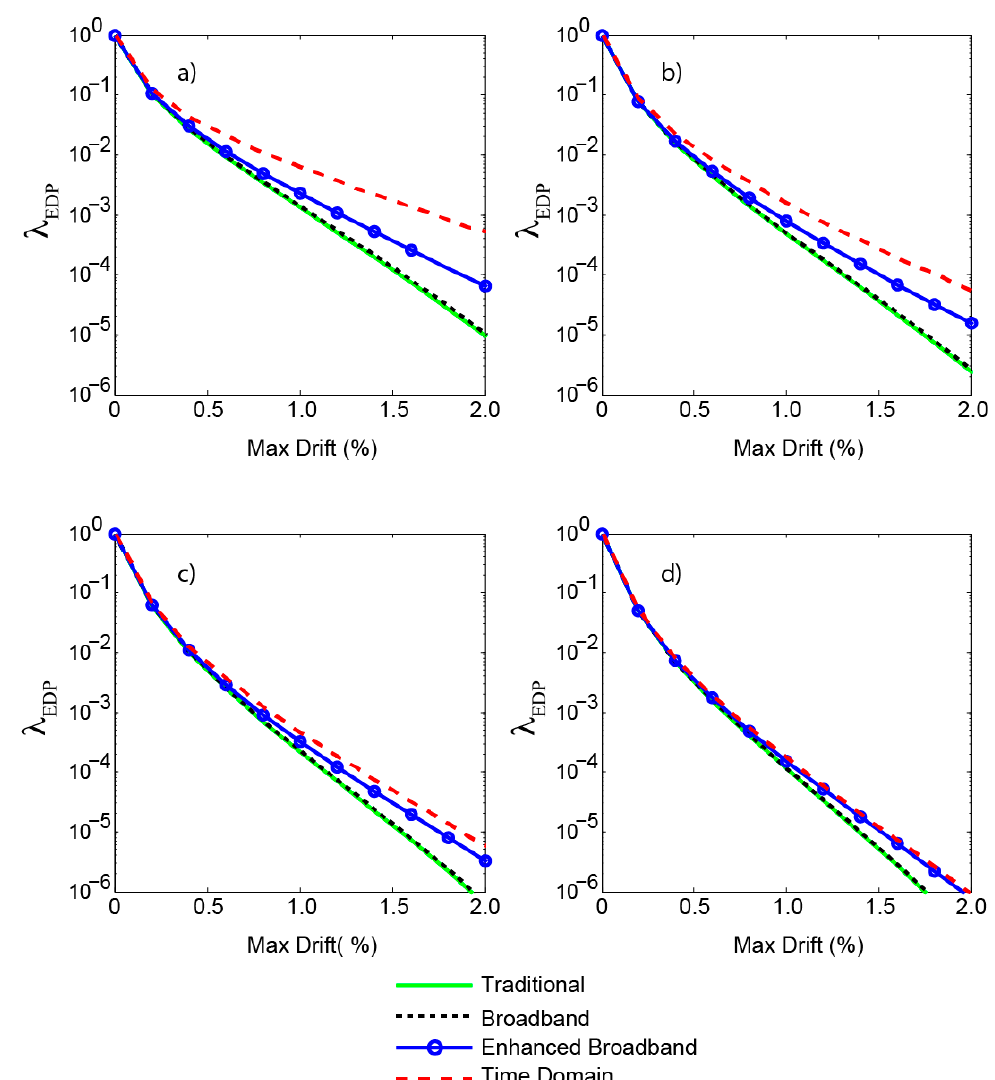
Figure 12. Rate of exceedance of drift vs. maximum drifts from the four methods (traditional, broadband, enhanced broadband and time–domain method) are shown for sites located at a distance of ( a ) 6 m, ( b ) 11 km, ( c ) 16 km, and ( d ) 21 km from the fault.